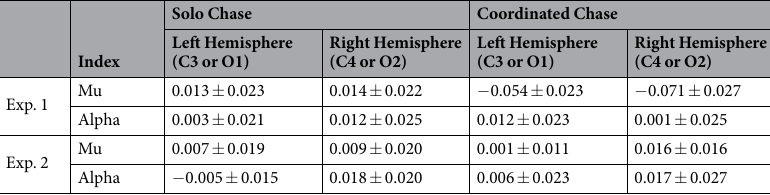
significant interaction effect between chase type and scalp location [ F (1, 23) = 4.65, p = 0.04, η p 2 = 0.17]. The simple effect test following this interaction effect indicated greater Mu suppression at central sites in the coor- dinated chase condition than in the solo chase condition ( p = 0.001), but indicated no significant Alpha index difference at the occipital sites between the coordinated and solo chase conditions ( p = 0.84). No significant effects were identified regarding either of the left main effects [hemisphere: F (1, 23) = 0.17, p = 0.68, η p 2 < 0.01; chase type: F (1, 23) = 2.61, p = 0.12, η p 2 = 0.10] or the other interaction effects [scalp location × hemisphere: F (1, 23) = 0.18, p = 0.67, η p 2 < 0.01; hemisphere × chase type: F (1, 23) = 1.19, p = 0.29, η p 2 = 0.05; scalp loca- tion × hemisphere × chase type: F (1, 23) < 0.01, p = 0.95, η p 2 < 0.01]. In addition, compared to its control con- dition baseline, the coordinated chase condition exhibited Mu suppression (i.e., Mu suppression was significant from zero; C3: t (23) = 2.38, p = 0.026, Cohen’s d = 0.49; C4: t (23) = 2.66, p = 0.014, Cohen’s d = 0.54; other tests: t s < 0.65, p s > 0.50]. Additionally, compared with the common resting state baseline (i.e., by pooling C3 and